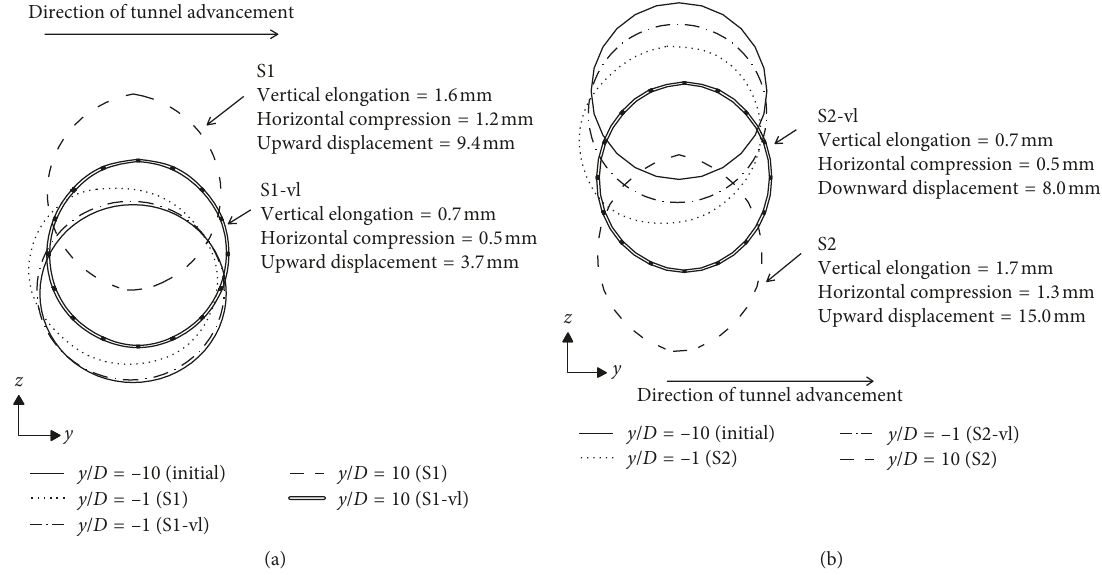
Figure 9: Displacement and deformation of the existing tunnel (not to scale) of (a) S1, case 1, and (b) S2, case